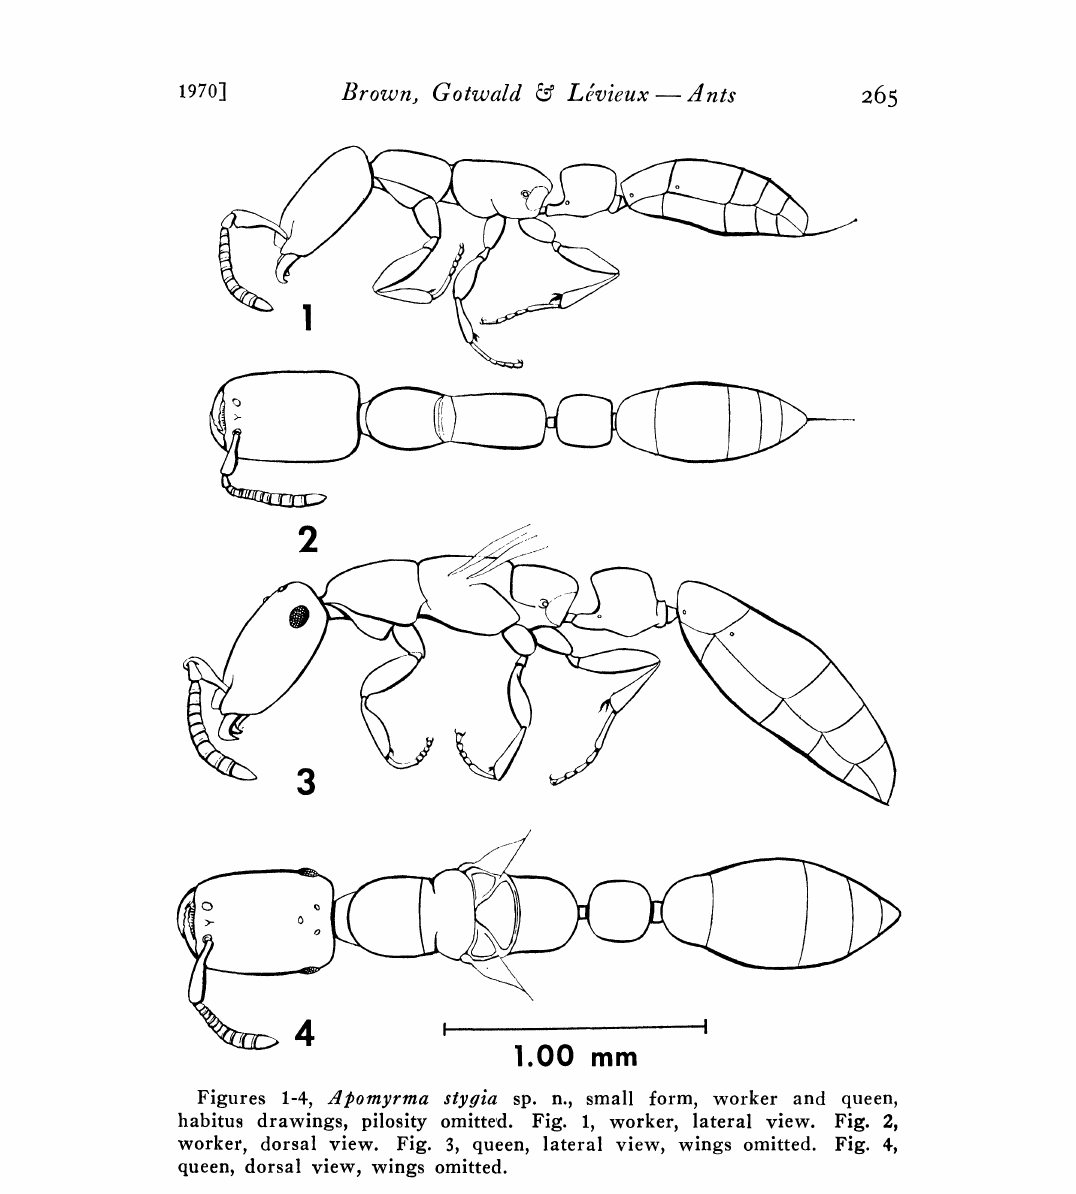
Figures 1-4, Alomyrma stygia sp. n., small form, worker and queen, habitus drawings, pilosity omitte’d. Fig. 1, worker, lateral view. Fig. 2, worker, dorsal view. Fig. 3, queen, lateral view, wings omitted. Fig. 4, queen, dorsal view, wings